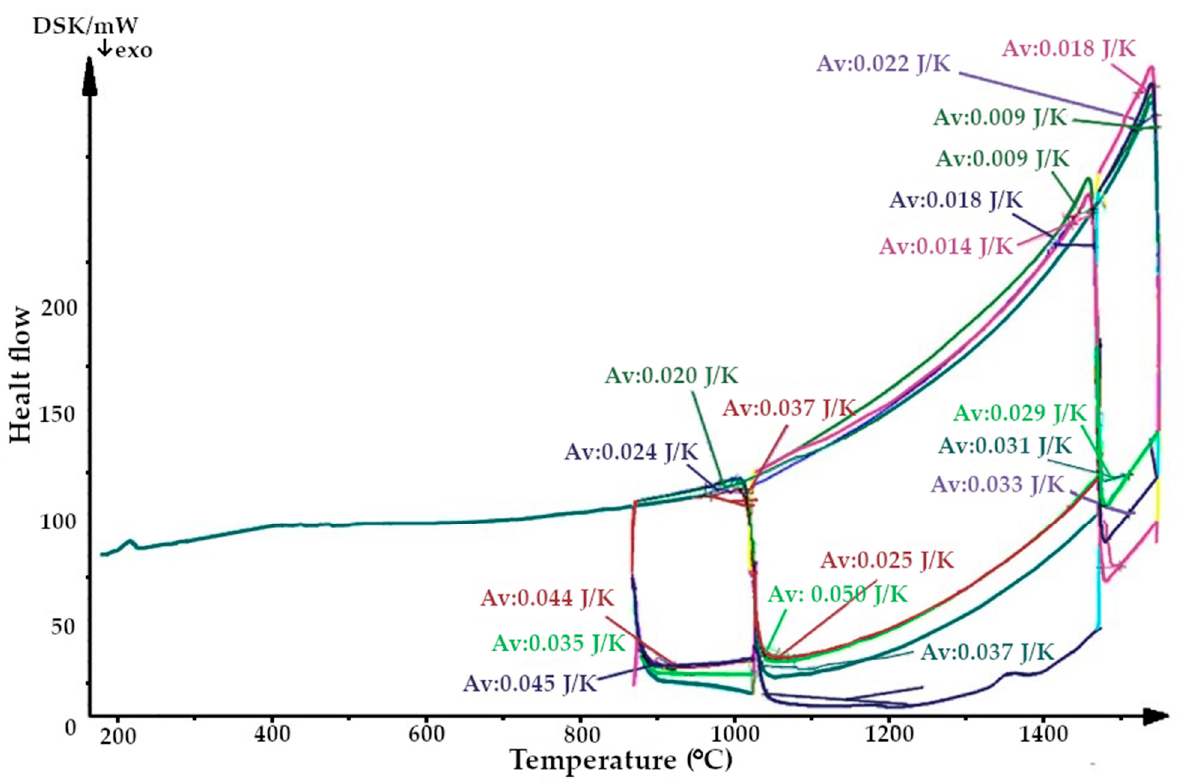
Figure 6. Thermogram of quartzite, calcified at 800 °C (Av, average heat capacity).